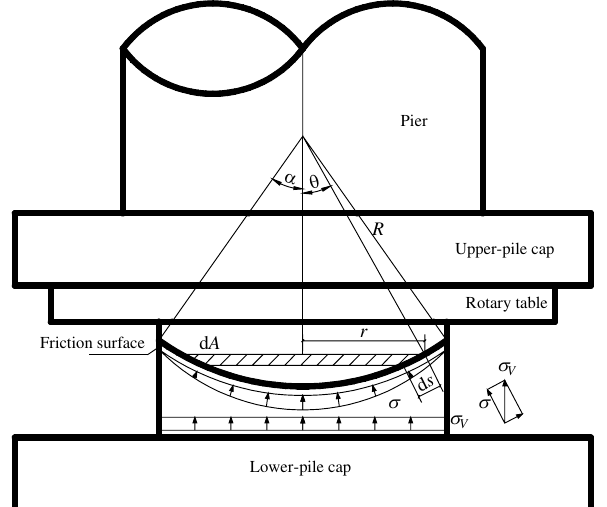
Figure 11. Calculating diagram of spherical hinge’s static friction